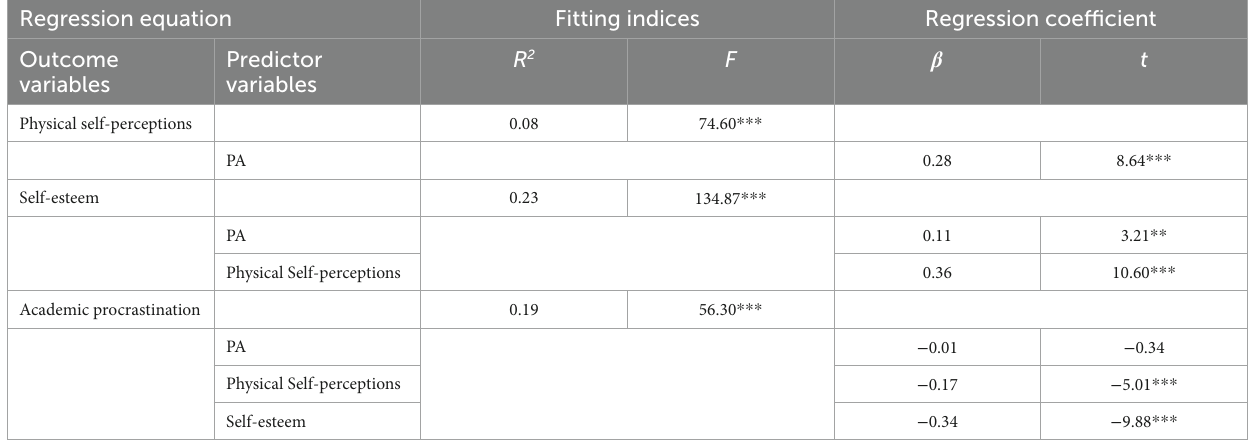
TABLE 3 Total, direct, and indirect effects of physical activity (X) on academic procrastination (Y) through physical self-perceptions (M1) and self- esteem (M2) ( N = 916). Effect